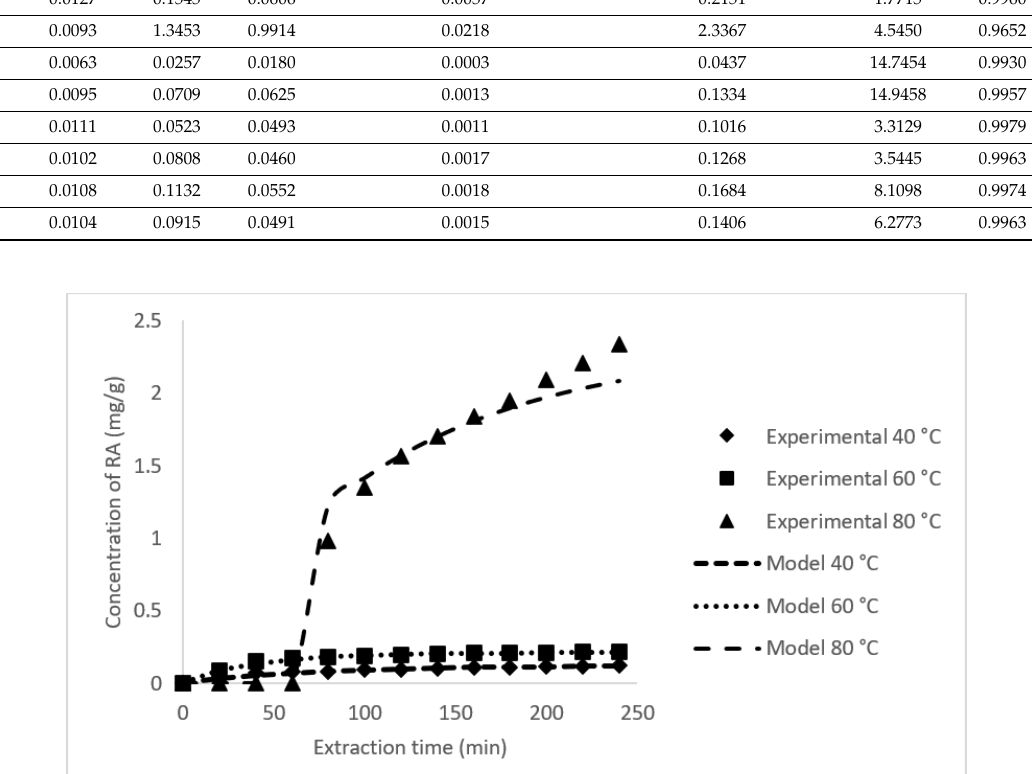
Figure 3. Extraction curve of RA extract from OS at constant pressure of 10 MPa.